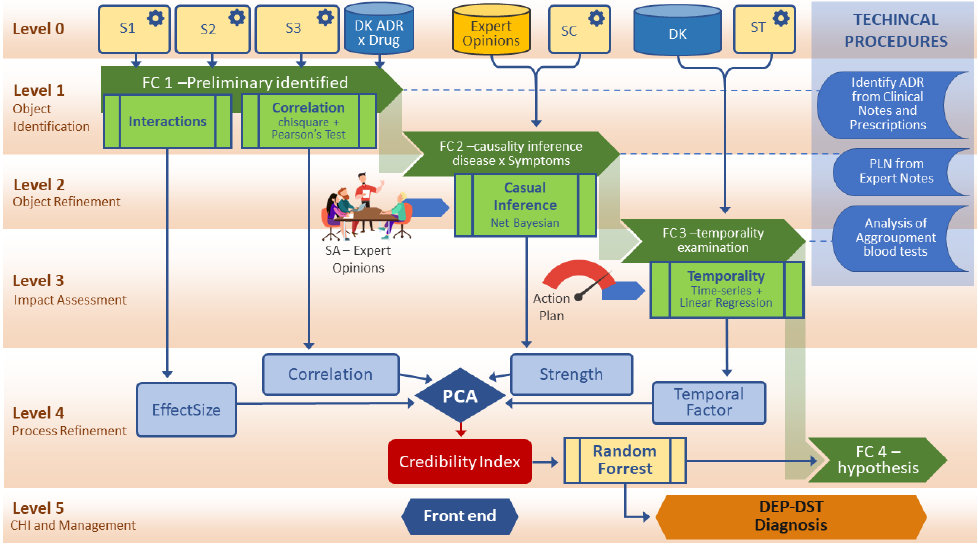
Figure 2. DEP-DST Model for dependence adjusts in